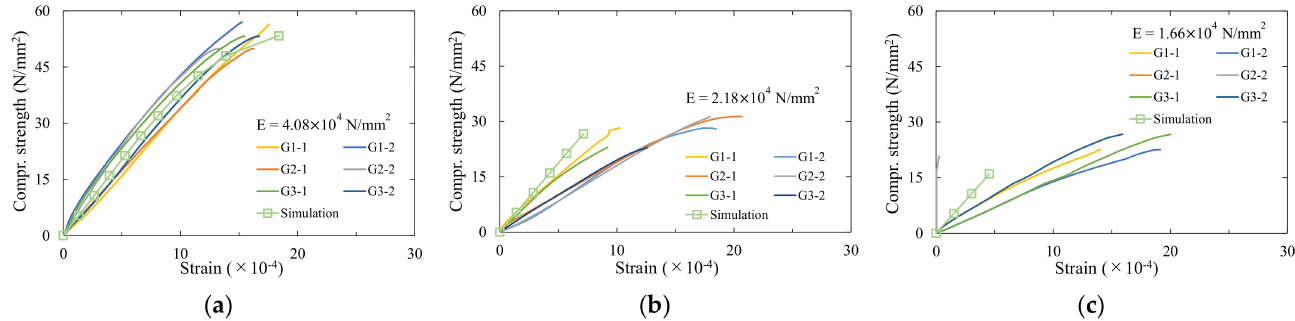
Figure 9. The stress–strain curve of SB concrete. ( a ) Conventional concrete. ( b ) SB30–56. ( c )